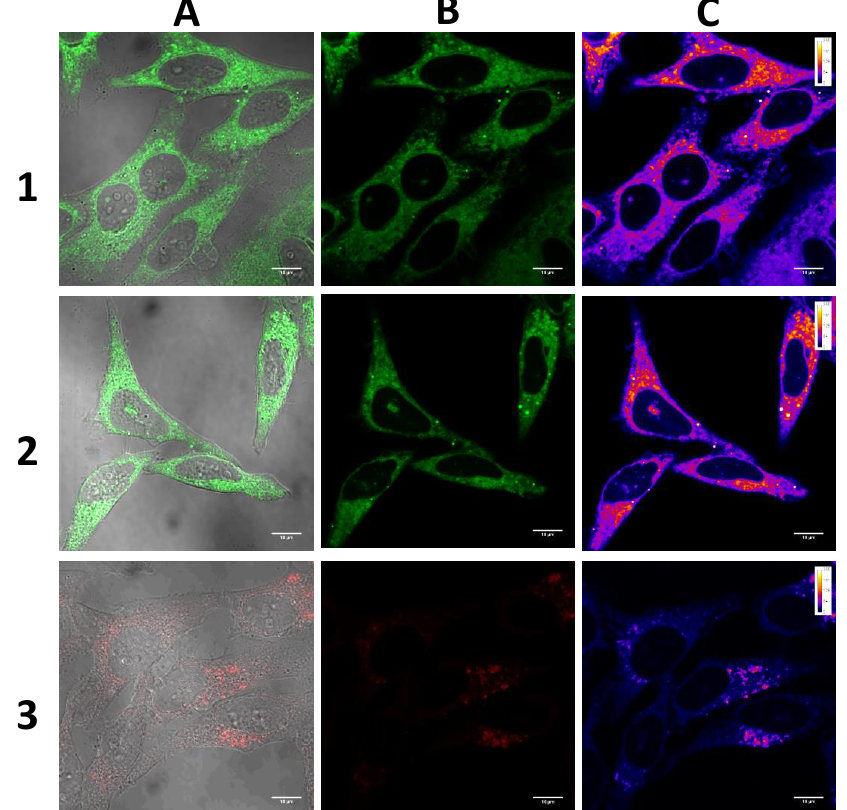
Figure 13. Confocal fluorescence microscopy image of HeLa cells stained with dyes 1 , 2 and 3 (10 µM) for 30 min. ( A ) Merged image of the fluorescence and bright-field images; ( B ) fluorescence image under excitation of 405 nm laser (2.0% for dyes 1 and 2 , 6.0% for dye 3 ); ( C ) the intensity of the signal was visualised using the “Fire” lookup table (LUT) colour scheme in Image J2. Linear mapping of pixel values in the display range indicated by the calibration bar (0 –255 a.u.). Scale bar: 15 µm.